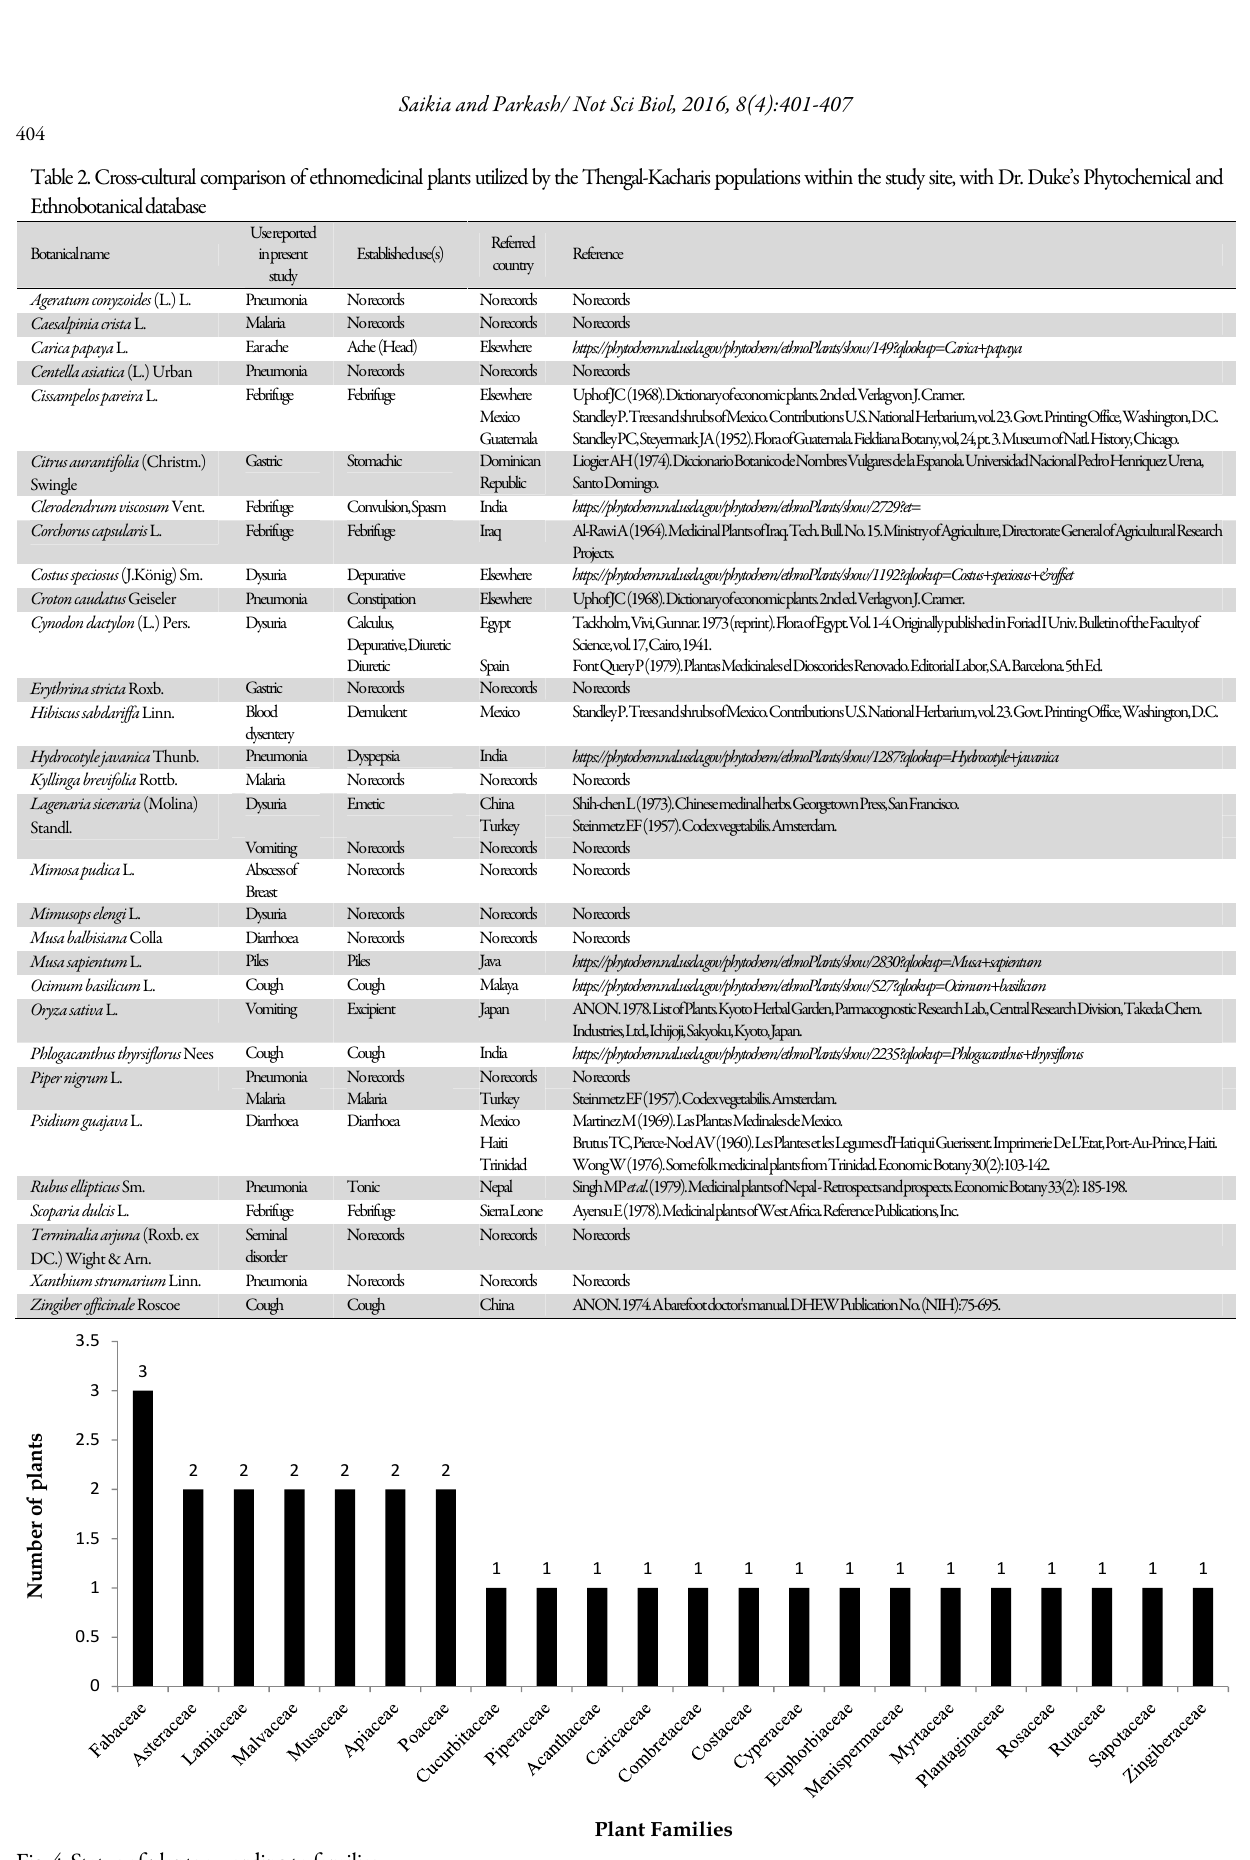
Fig. 4. Status of plants according to